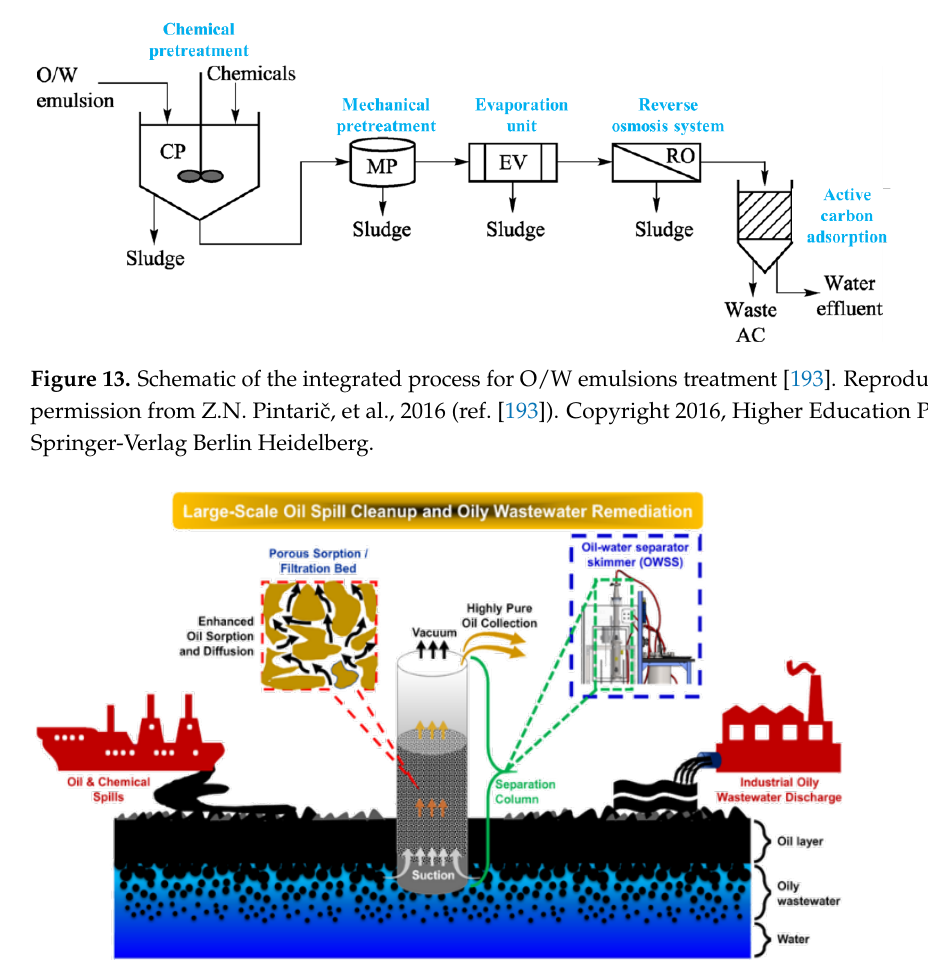
Figure 14. Schematic illustration for typical large-scale implementation of the developed oil–water separator skimmer using porous sorbent materials [194]. Reproduced with permission from Abidli et al., 2020 (ref. [194]). Copyright 2020 Elsevier B.V.